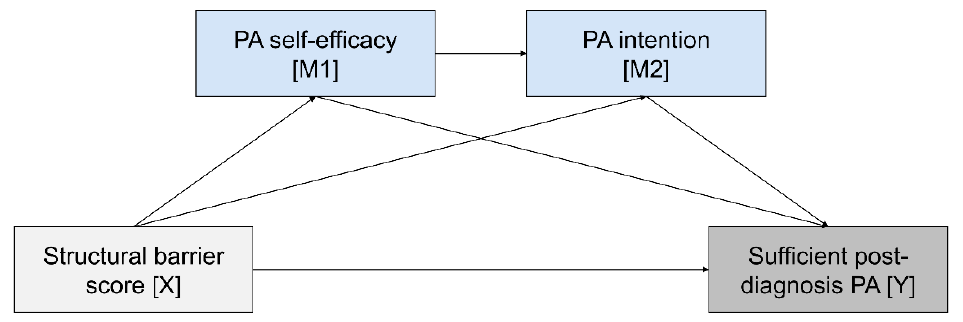
Figure 1. Conceptual research model with the effect of structural barriers on post-diagnosis physical activity being mediated through social-cognitive factors.